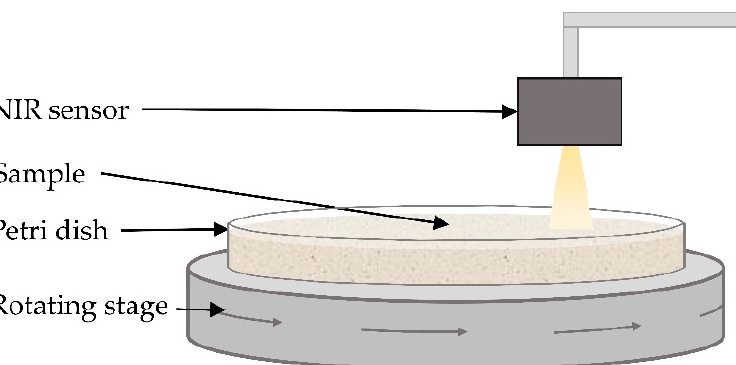
Figure 1. A diagram of the experimental setup. Two NIR sensors were used (S2.0 and S2.5). The distance between the NIR sensors and the sample surface was 2 cm. Samples weighing 100 g were measured in a 12 cm-diameter petri dish. The samples were measured under stationary conditions and at three speeds (slow—0.017 ms − 1 , medium—0.036 ms − 1 , fast—0.068 ms − 1 ) using the rotating